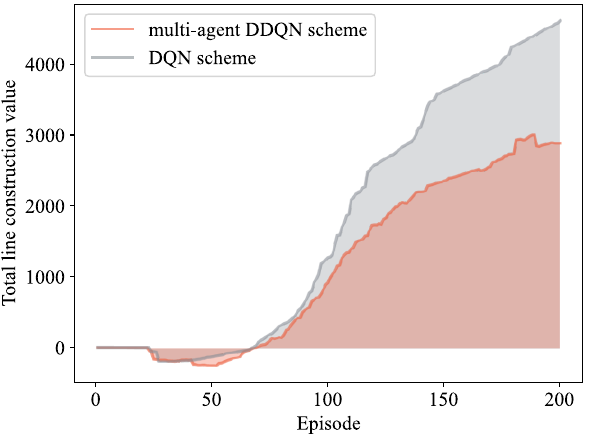
Figure 14. The sum of value prediction between multi-agent DDQN and DQN in 200 episodes.